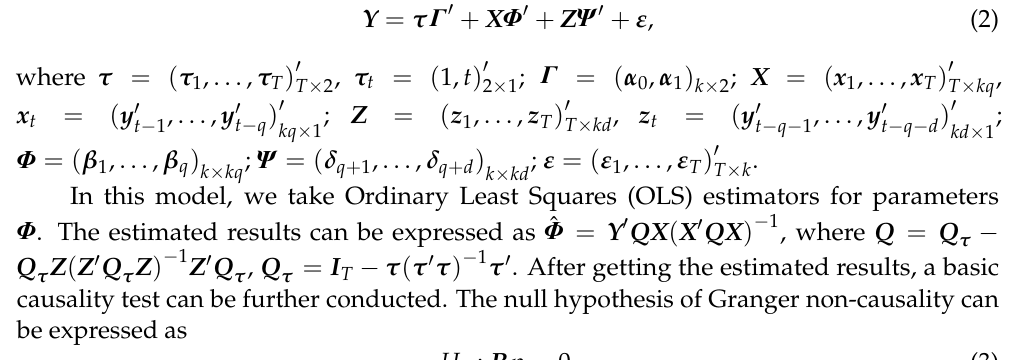
Table 2. Descriptive statistics.